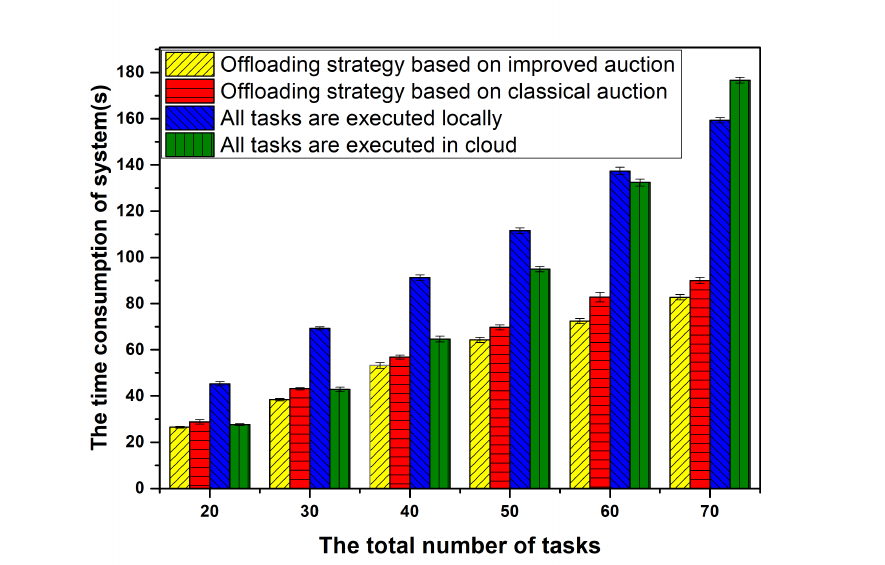
Figure 12. The time consumption of four algorithms over the different number of